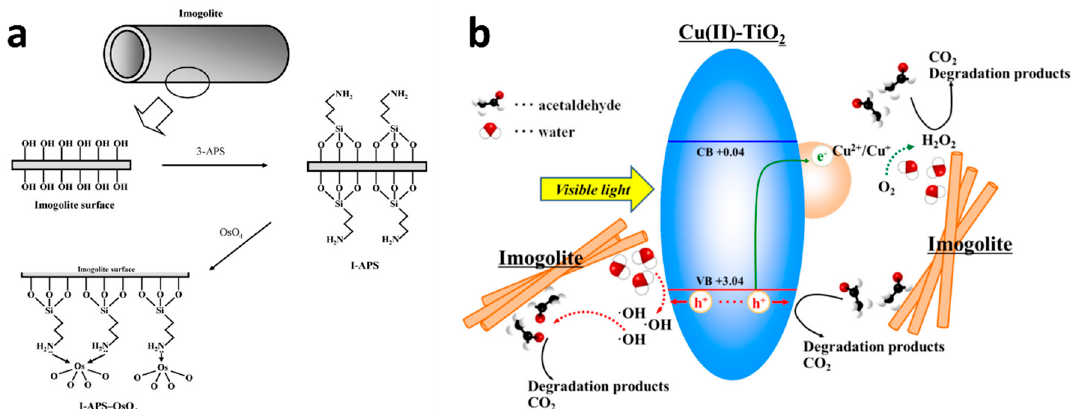
Figure 14. ( a ) Surface-modified imogolite with 3-aminopropyltriethoxysilane (3-APS)–OsO4 complex for the dihydroxylation of olefins. Adapted with permission from [91]; ( b ) proposed photodegradation mechanism of acetaldehyde under visible light irradiation by Cu(II)-graftedTiO 2 / INT composite based on (OH) 3 Al 2 O 3 Si(OH). Adapted with permission from [92].